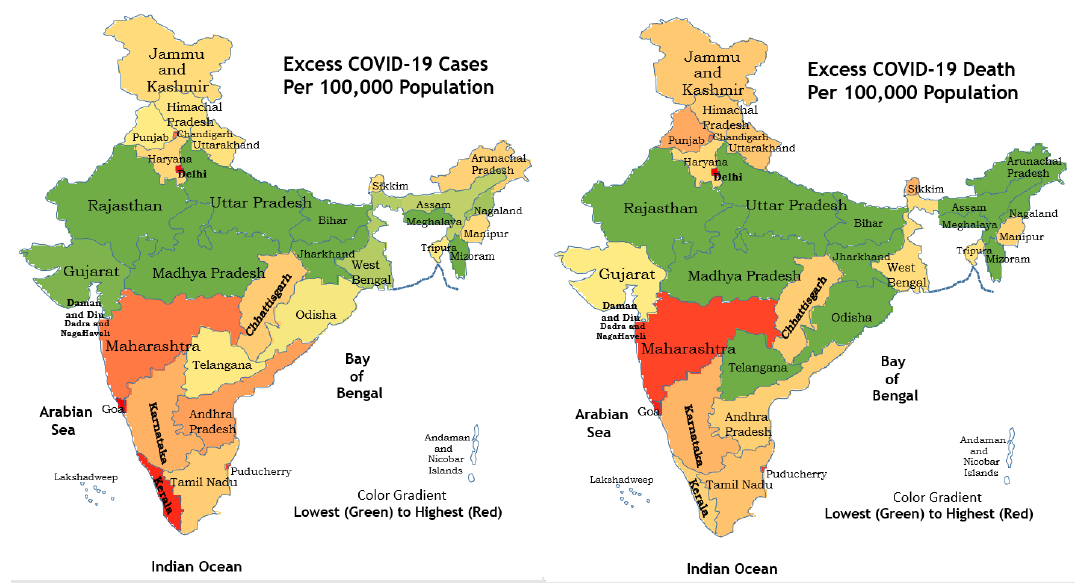
Figure 1. Visualization of Excess Cases Figure 2. Visualization of Excess